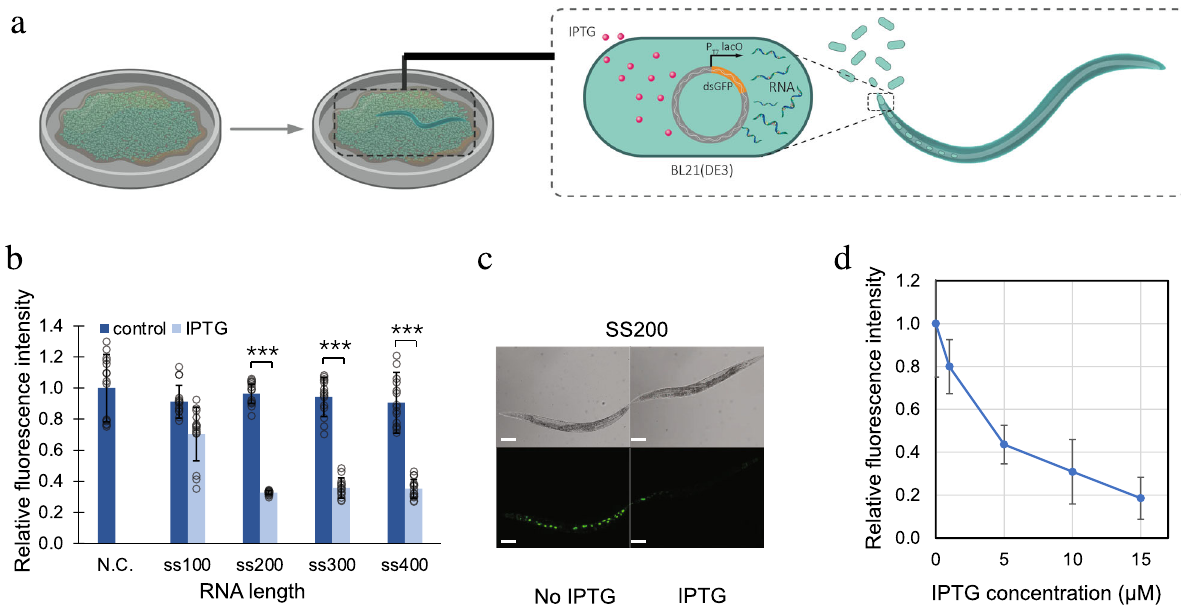
Fig. 2 Using RNA in ingested bacteria to silence GFP in C. elegans . a Schematic of engineered E. coli triggering RNAi in C. elegans through feeding. b Quanti fi cation of C. elegans GFP fl uorescence intensity controlled by bacteria yielded single-stranded gfp RNA of various lengths with no IPTG and 1 mM IPTG. c Optical and fl uorescent images of C. elegans SD1084 GFP expression programmed by bacterial single-stranded 200 bp gfp RNA (ss200) with no IPTG and 1 mM IPTG. Scale bar, 100 µ m. The experiment was repeated three times independently for a total of 15 worms with similar results. d C. elegans SD1084 GFP intensity change caused by varying IPTG concentration-induced RNA synthesis. (*** P < 0.001 using two-sided t- test. Error bars represent the mean ± standard deviation for n = 15 worms over three independent experiments). Source data are available in the Source Data fi